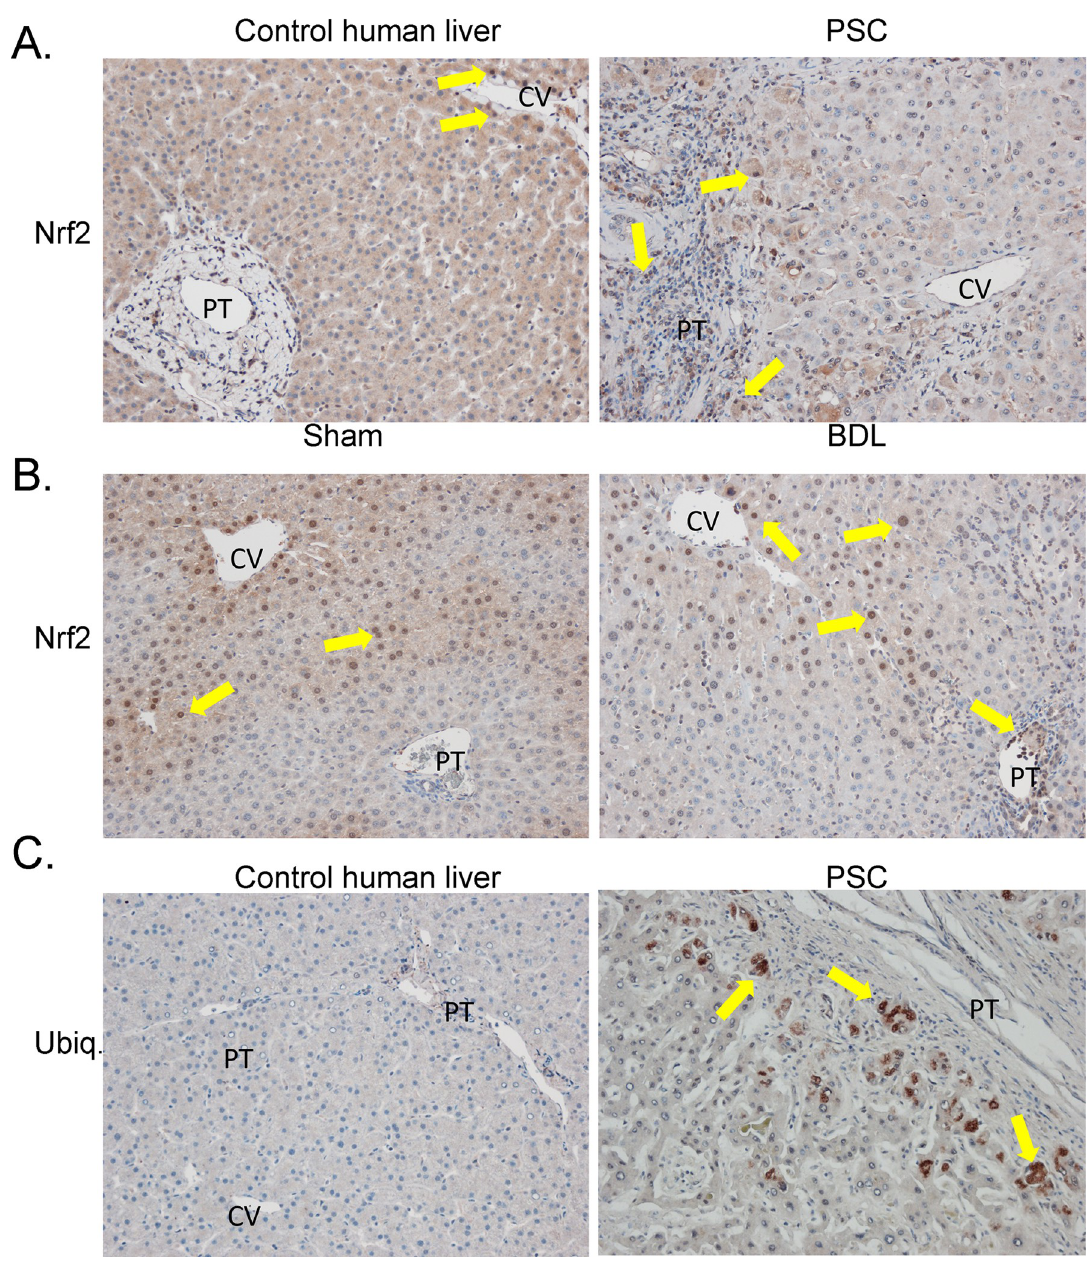
Fig 6. Increased periportal nuclear localization of Nrf2 in human and murine cholestasis. Tissue sections were examined for Nrf2 nuclear localization A . Normal human liver, PSC (200X). B . Sham mice and BDL mice (100X). C . Accumulation of ubiquitinated proteins in parenchymal cells surrounding the injured portal triad in PSC. n = 3-4/group, (200X). CV-central vein, PT-portal triad. Arrows indicate increased periportal staining. liver samples [22]. Data in Fig 6 supports Nrf2 activation during cholestasis. To determine if oxidative stress similarly impacted cellular antioxidant responses in an acute cholestasis model, the expression in 3-day BDL mouse liver of the Nrf2 regulatory and response proteins Kelch-like ECH-associated protein 1 (Keap1), GCLC, HO-1, GST μ and carbonyl reductase 3 (Cbr3) was examined and quantified by Western blot analysis ( Fig 7A ). Following 3-day BDL,